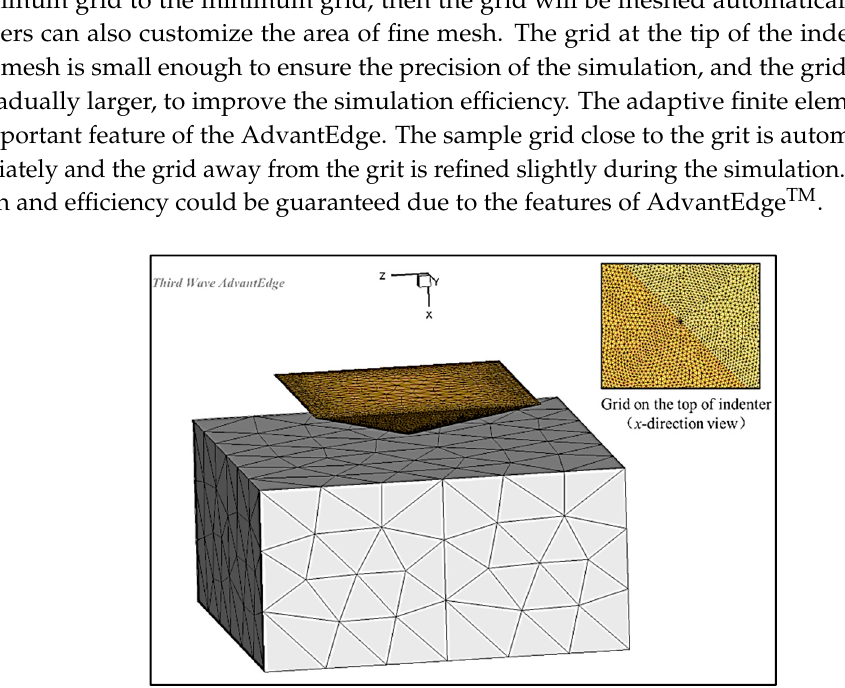
Figure 6. The geometrical model.